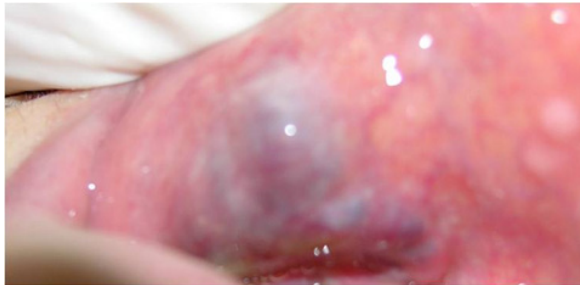
Figure 1: Lesion of the lower left lip.